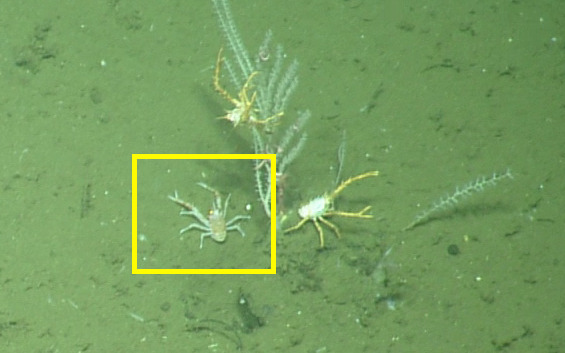
Munida sp. indet. 2